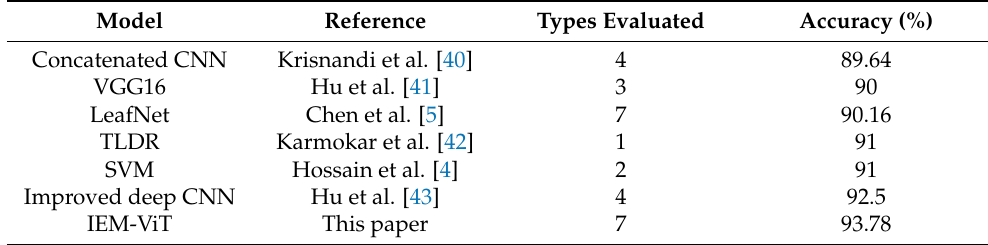
Table 3. Comparison of the proposed IEM-ViT and other methods.